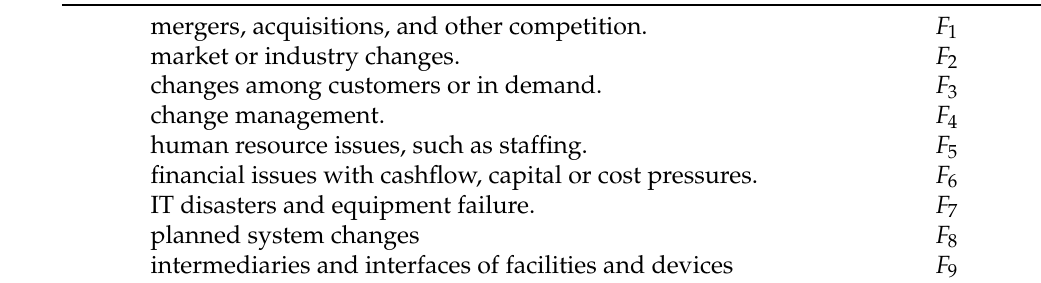
Table 18. Failure modes.